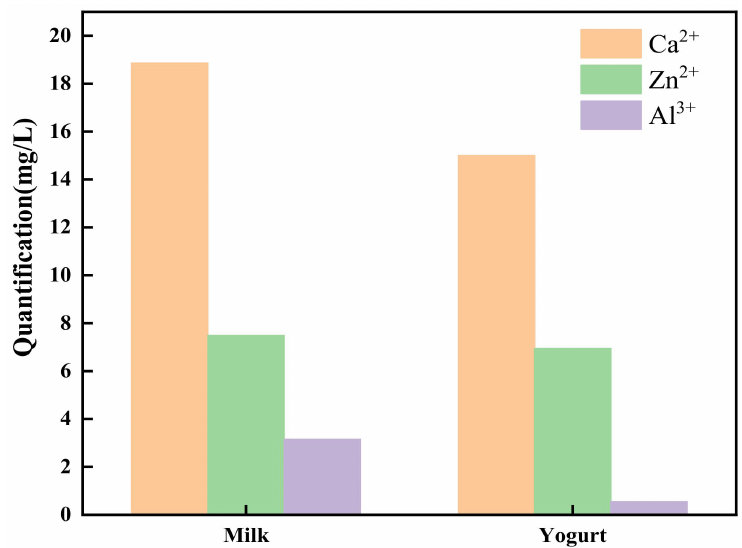
Figure 7. Migration of Ca 2+ , Zn 2+ and Al 3+ in PET/HTLc-1.5 film after 10 days in milk and